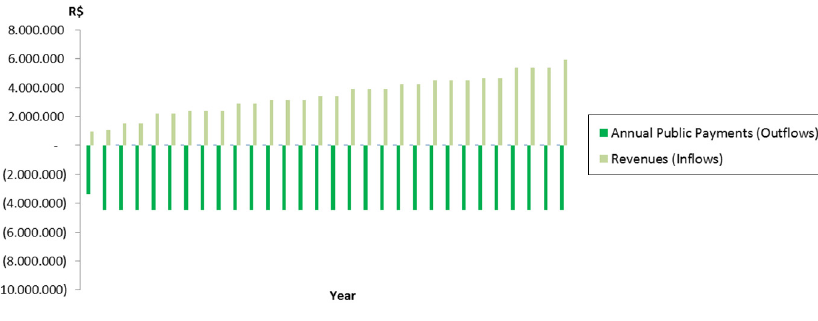
Figure 3. Project cash fl ow in the PPP